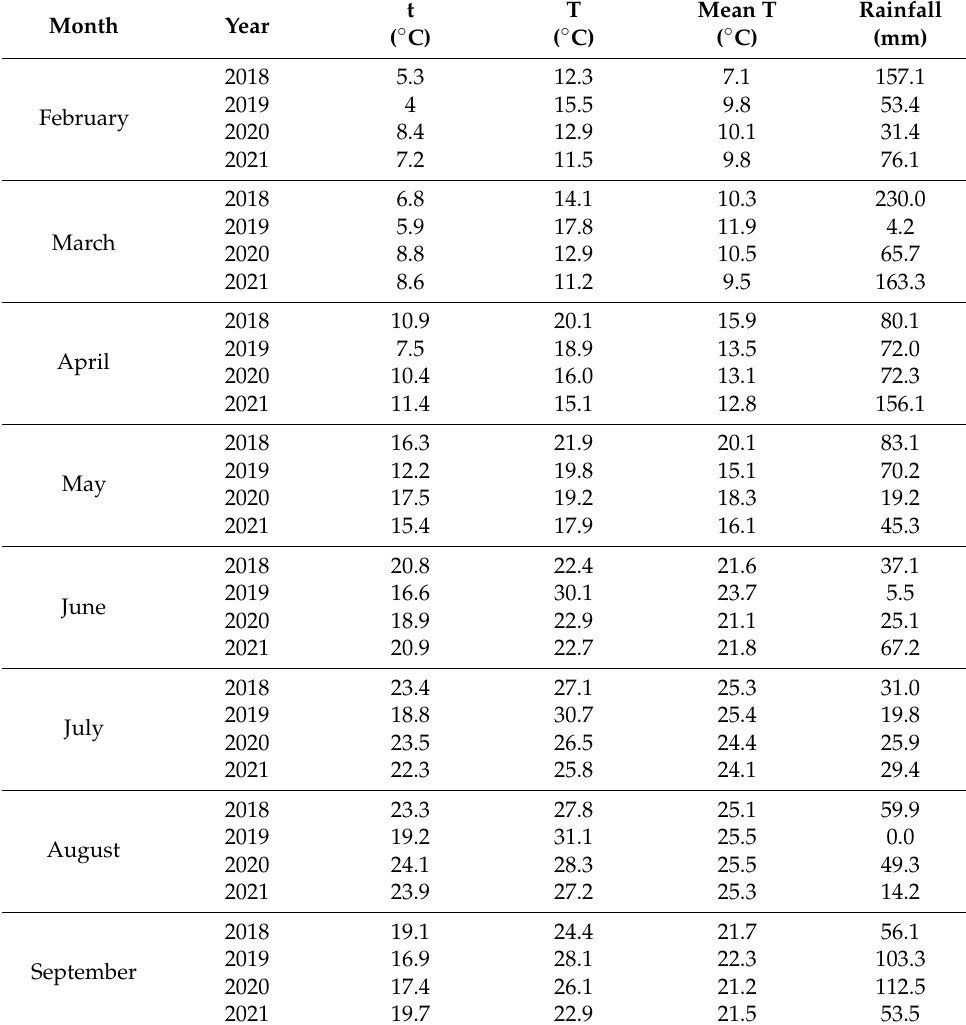
Table 1. Minimum (t), maximum (T) and mean monthly temperature (mean T) and sum monthly precipitation (rainfall) at the experimental farm ARSIAL-Tarquinia (Viterbo province-Italy) in the period February to September, of the four years of investigation